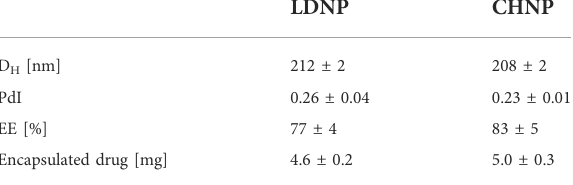
TABLE 2 Characterization of LDNP and